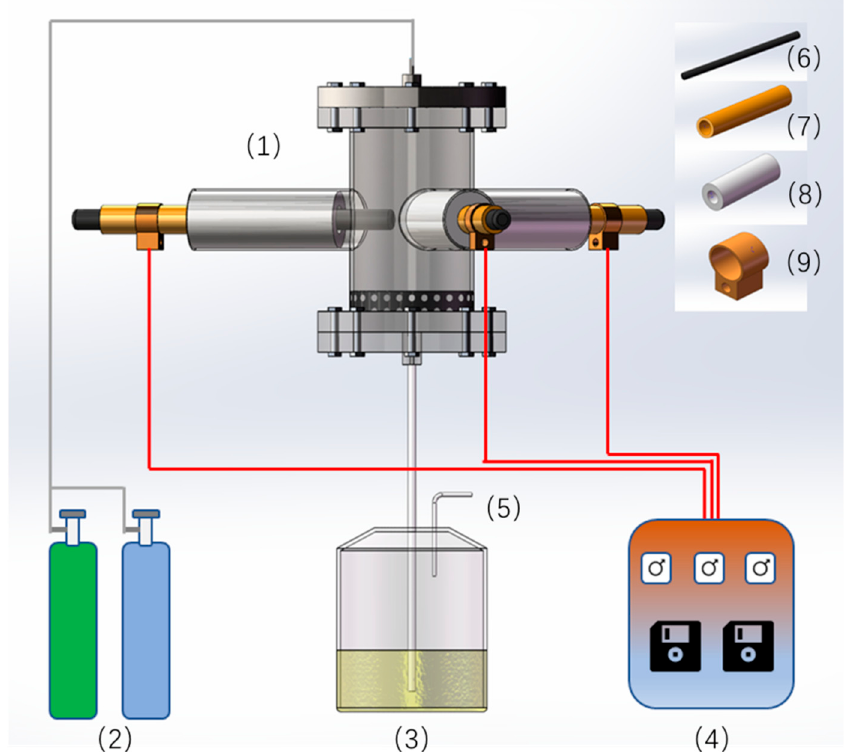
Figure 1. Illustration of the three-phase AC arc plasma device. (1) pyrolysis reactor; (2) gas supplier; (3) oil collector; (4) powder supplier; (5) gas collector; (6) graphite rod; (7) copper tube; (8) electrode jackets; (9) electrode connector.